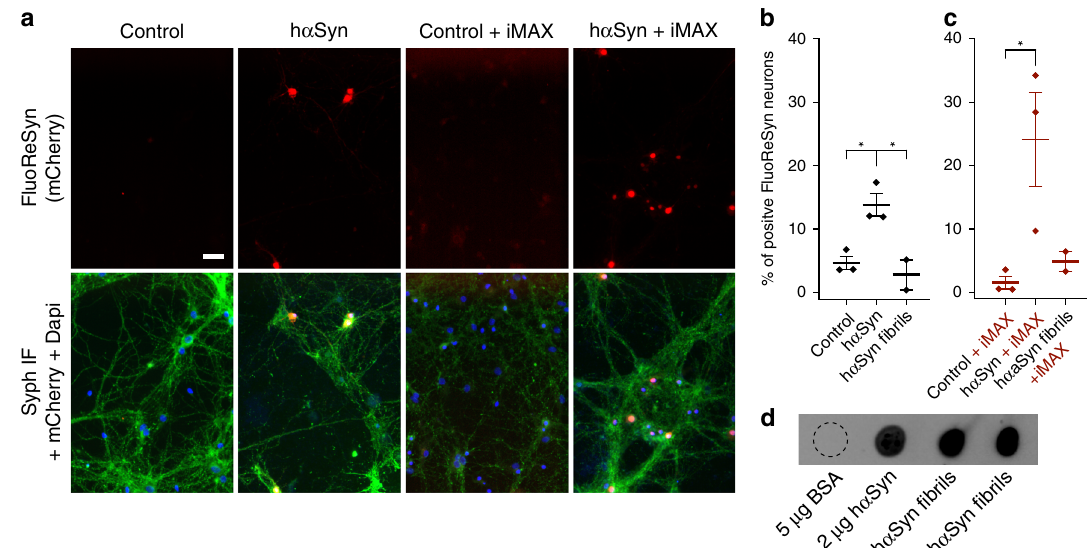
Fig. 6 Detection of h α Syn monomers added to the medium of cultured neurons. a Equally scaled, representative images of primary rat hippocampal neurons infected with adeno-associated virus (AAV) encoding for NbSyn87-mCherry-NLS (a red version of the FluoReSyn). The cultures were then exposed to 20 µ M of monomeric h α Syn, with or without RNAiMAX (iMAX), for 14 h. Immuno fl uorescence against synaptophysin was used as a neuronal marker (Syph IF, green signal). The negative controls were neurons receiving Opti-MEM with or without RNAiMAX. Scale bar represents 20 µ m. b , c Quanti fi cation of FluoReSyn signal-positive neurons. One-way ANOVA with multiple comparison Tukey test * p < 0.05. Error bars represent the SEM, each point in the scatter plot represents the average of an independent experiment d Monomeric untagged h α Syn and two different batches of in vitro produced h α Syn fi brils were spotted on a nitrocellulose membrane and were detected by NbSyn87-Alexa647, which con fi rmed the ability of NbSyn87 to bind the fi brils used in hippocampal cultures. Bovine serum albumin (BSA) was used as negative control. Source data is available as a Source data fi